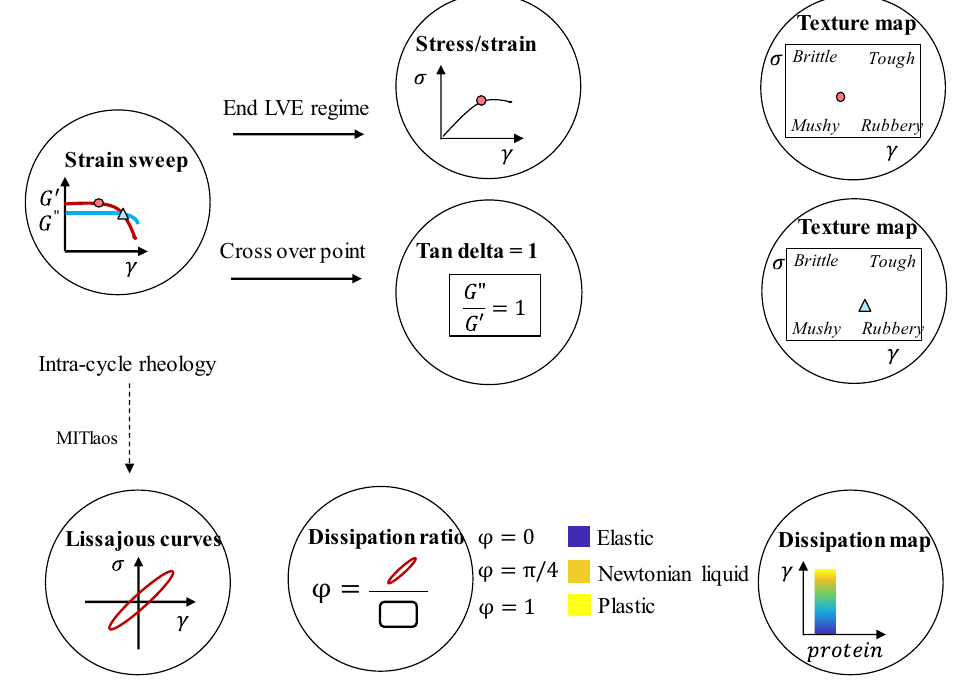
′ " ) and loss modulus ( G ) versus strain to define the crossover point ( G